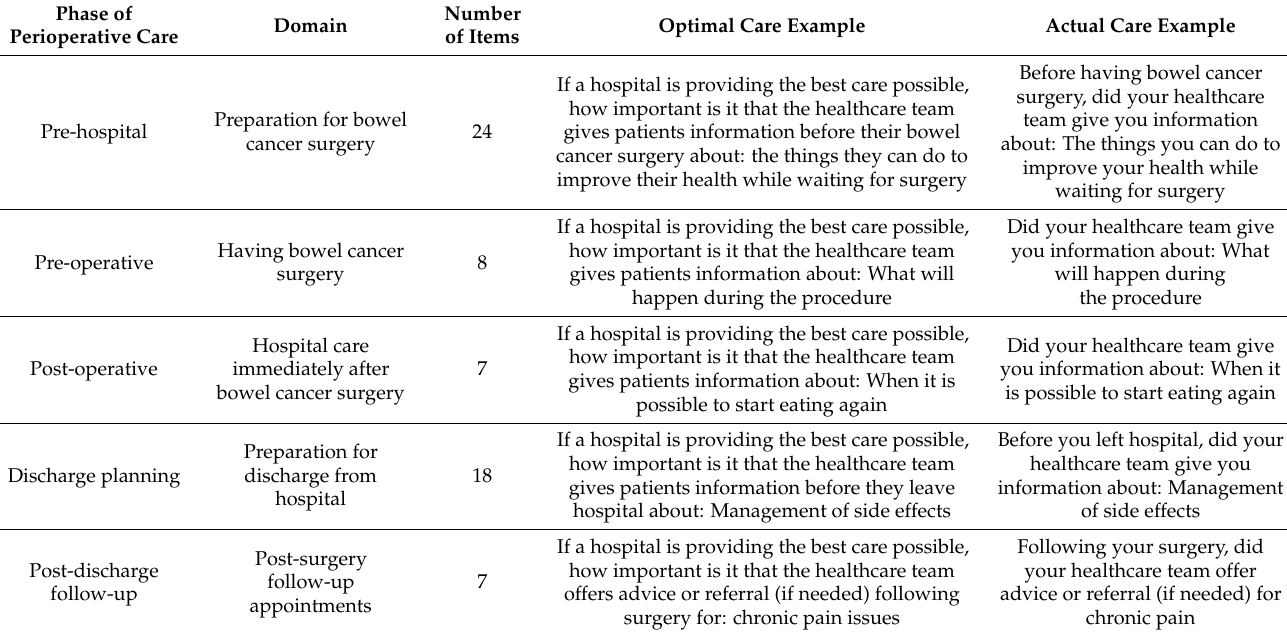
Table 1. Summary of survey domains and items by phase of perioperative